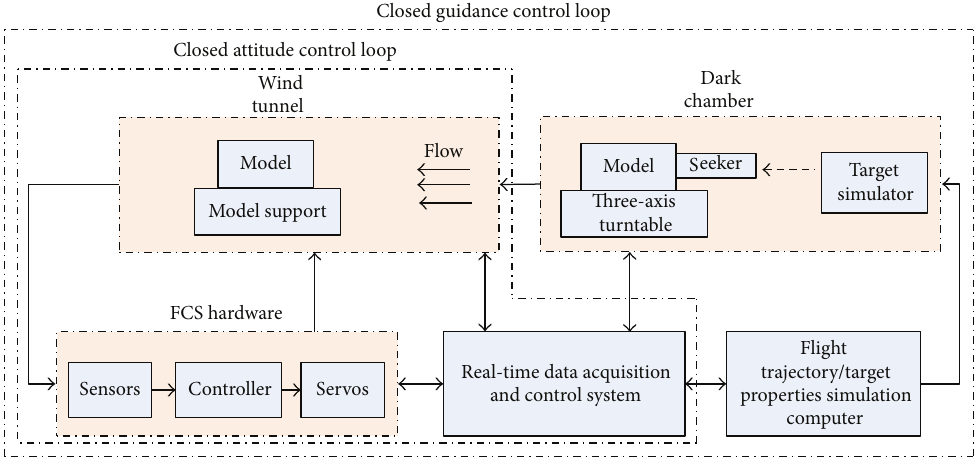
Figure 29: Compositions of a complete VFT